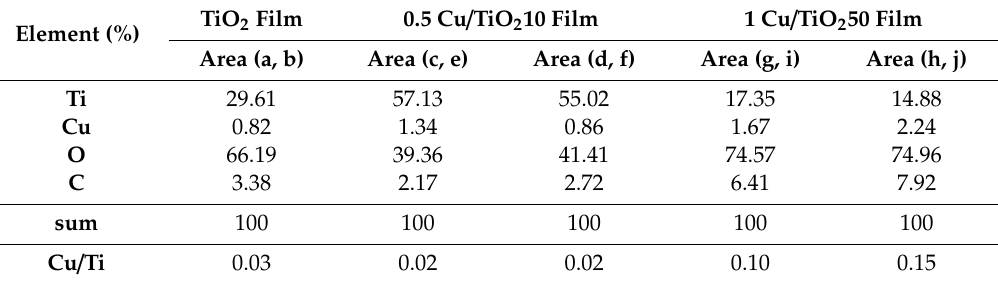
Figure 3. Scanning electron micrographs of Cu / TiO 2 -TiO 2 composite films ( A , E , and I (magnification: × 15 K) and C , G , and K (magnification: × 50 K)) and EDX spectrum of the Cu / TiO films ( B , D , F , H , J , L ). Table 1. Average percentage of element in the nanocomposite